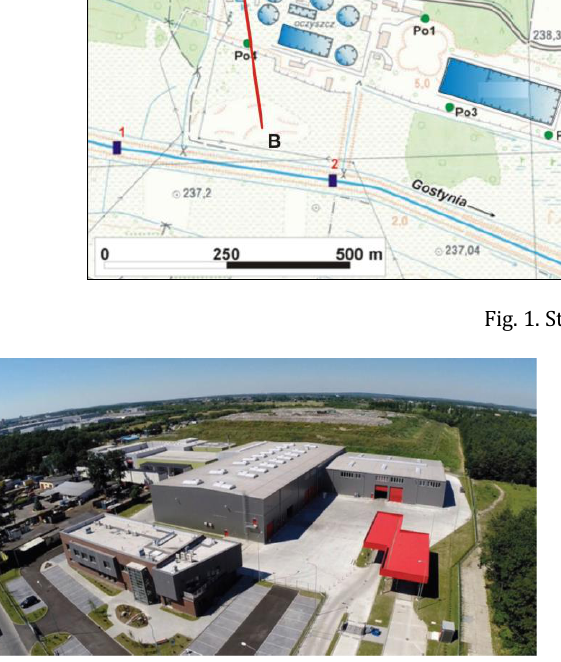
Fig. 2. MASTER company